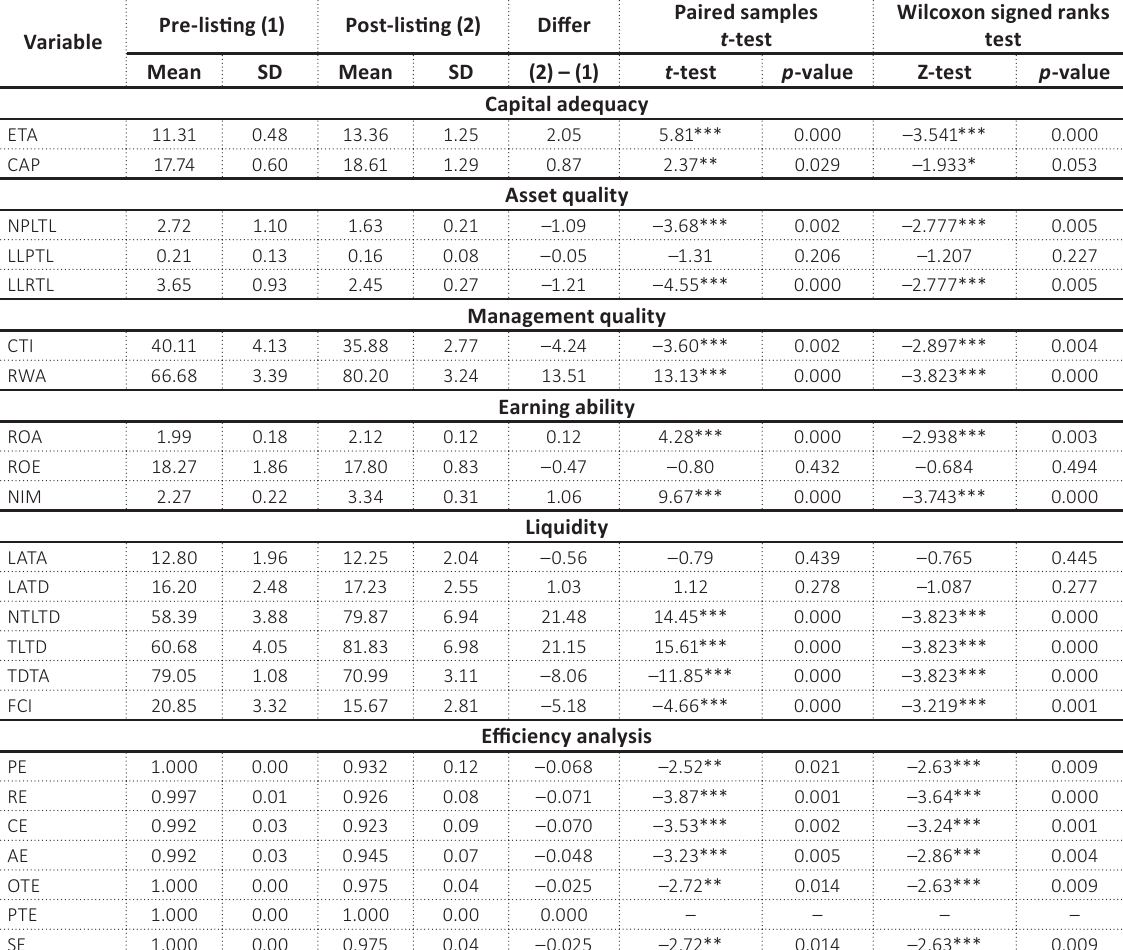
Table 3. The results of the pre- and post-listing empirical design of the NCB